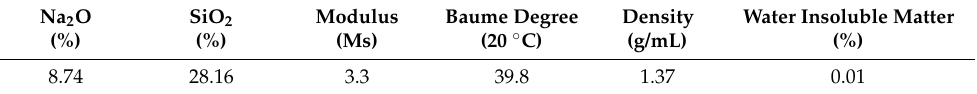
material. Table 3. Physical and chemical parameters of the sodium silicate